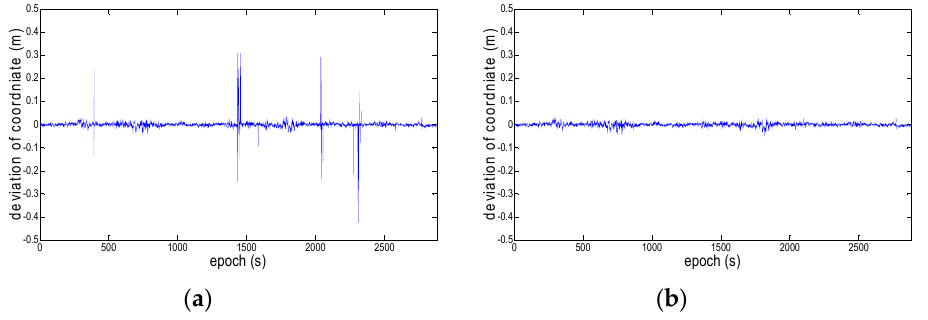
Figure 7. Deviation of coordinate (Up). ( a ) without robust estimation; ( b ) with robust estimation. Table 1. The distribution of coordinate deviation (%).